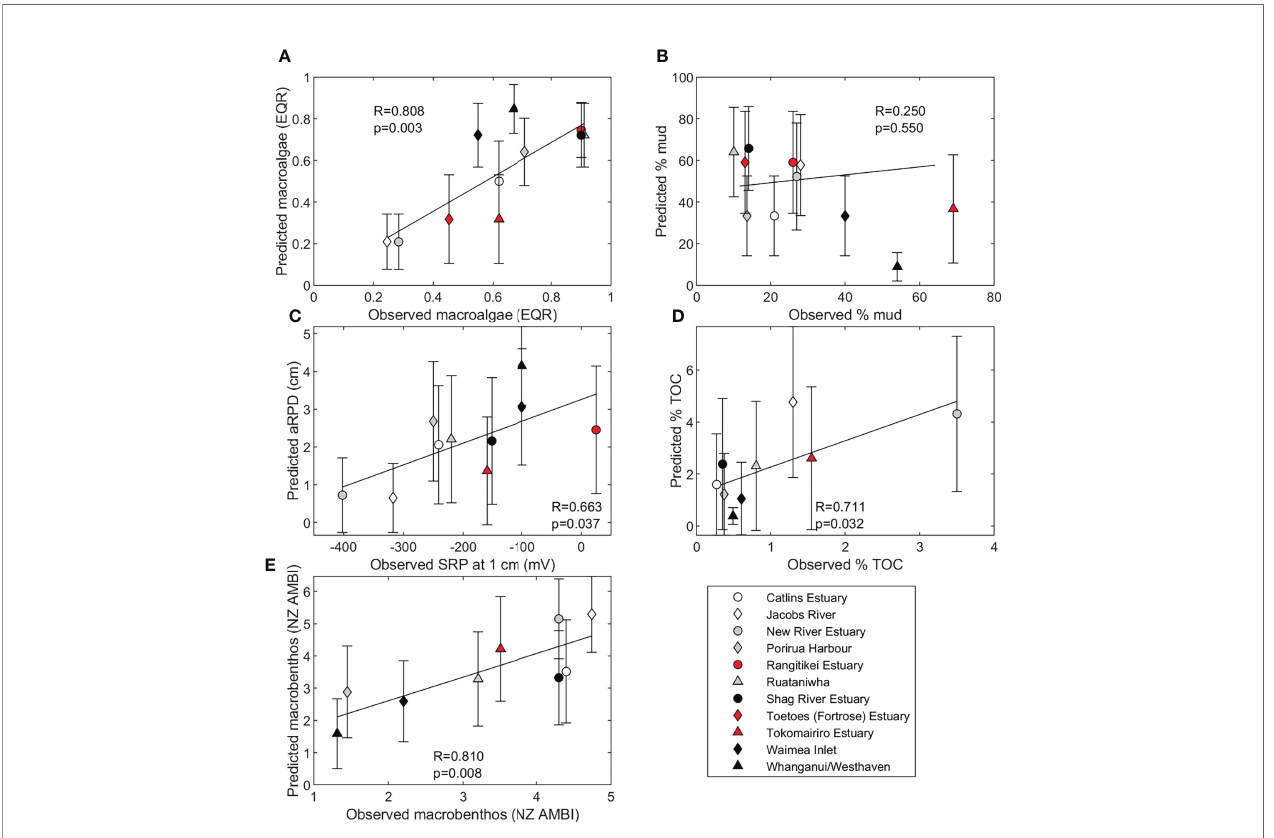
( Figure 5C ) as were predicted and observed % TOC ( Figure 5D ). Observed and predicted % mud were not correlated ( Figure 5B